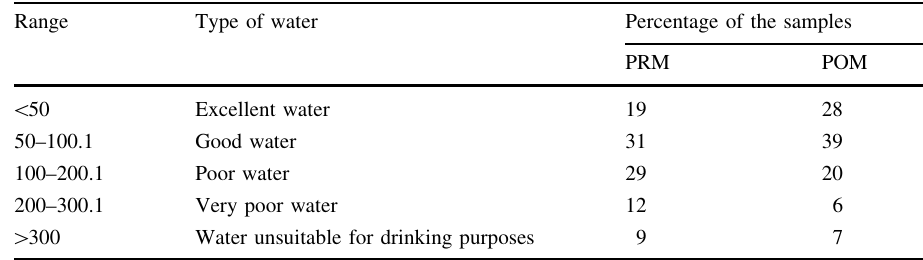
Table 4 The WQI range, type of water and percentage of the water samples during PRM and